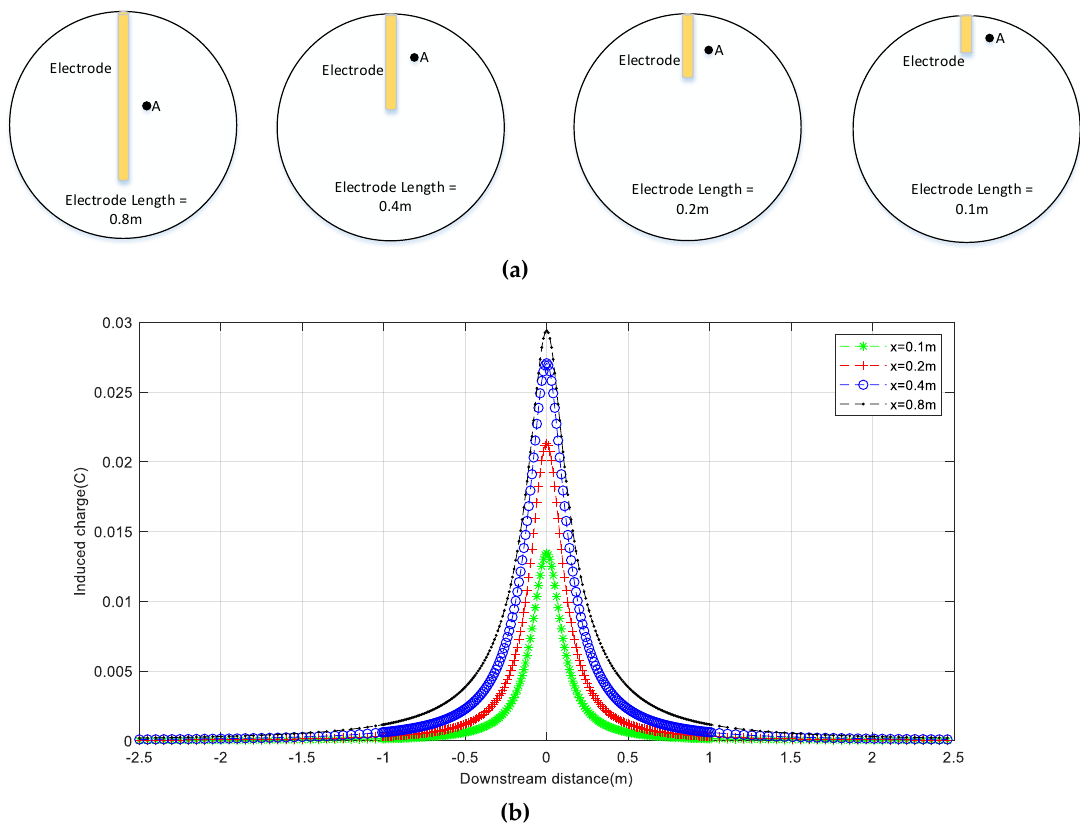
Figure 11. ( a ) Electrodes of different lengths and positions of the point charge; ( b ) induced charge distribution on electrodes of different lengths.